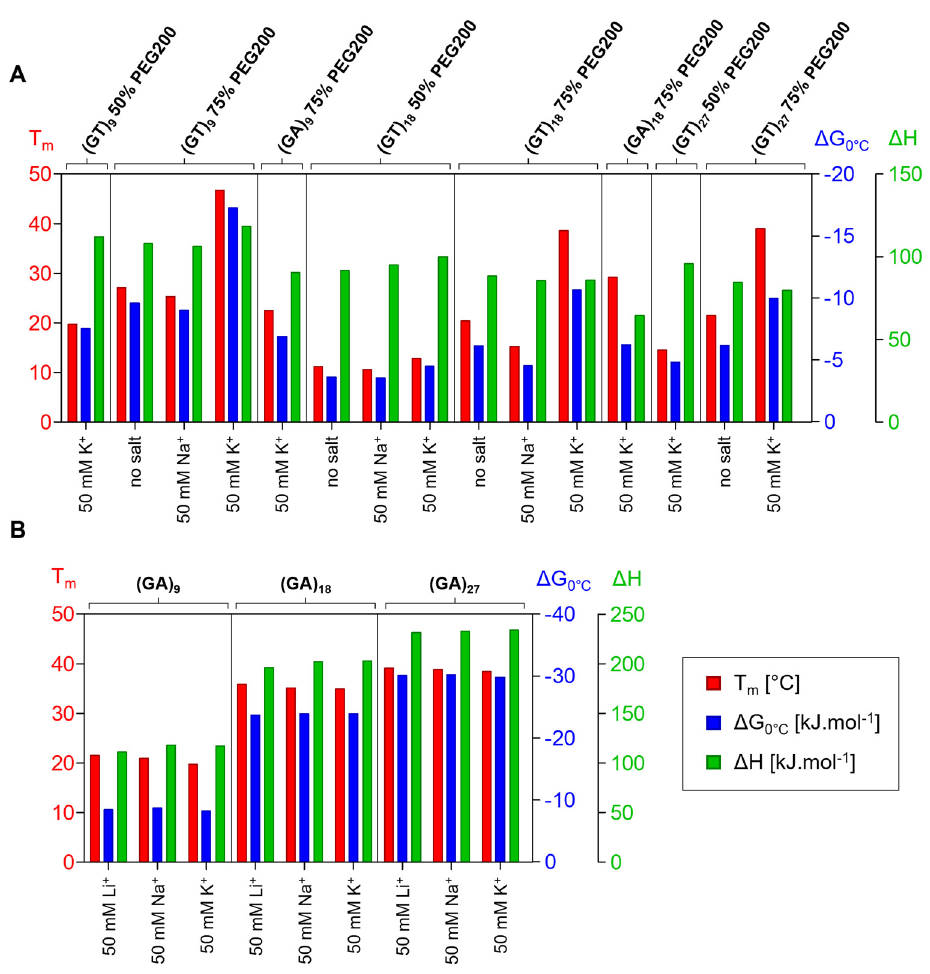
Figure 6. Graphical representation of the data from Supplementary Table S2: melting temperatures (red) and corresponding Δ G calculated at 0 °C (blue) and Δ H (green). The thermodynamic parameters for the Z-G4 structures under molecular crowding conditions are shown in ( A ) and for the AGAG- tetrahelical structures in ( B ).